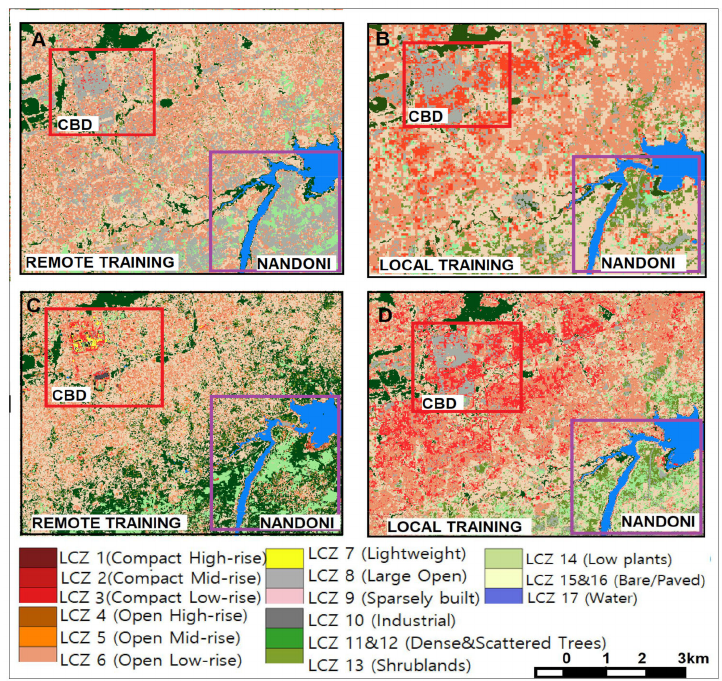
Figure 9. Single image ( C , D ) and multi-temporal ( A , B ) classifications of Thohoyandou using a standardized remote ( A , C ) and local ( B , D )